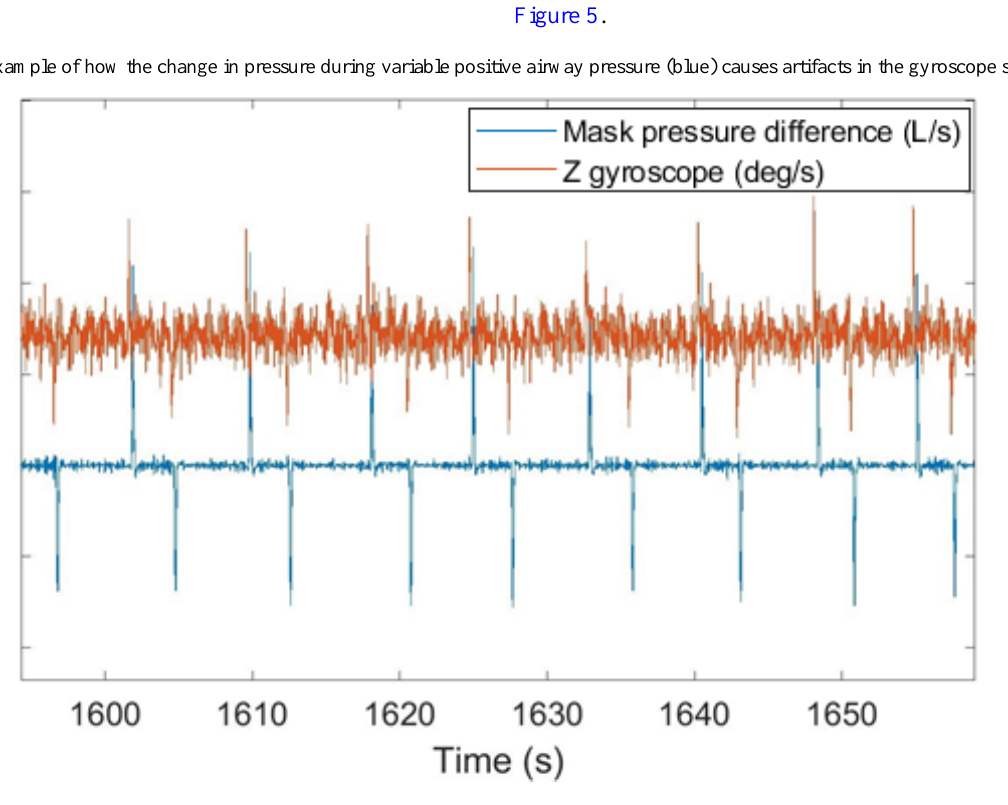
Normalized gyroscope, me-